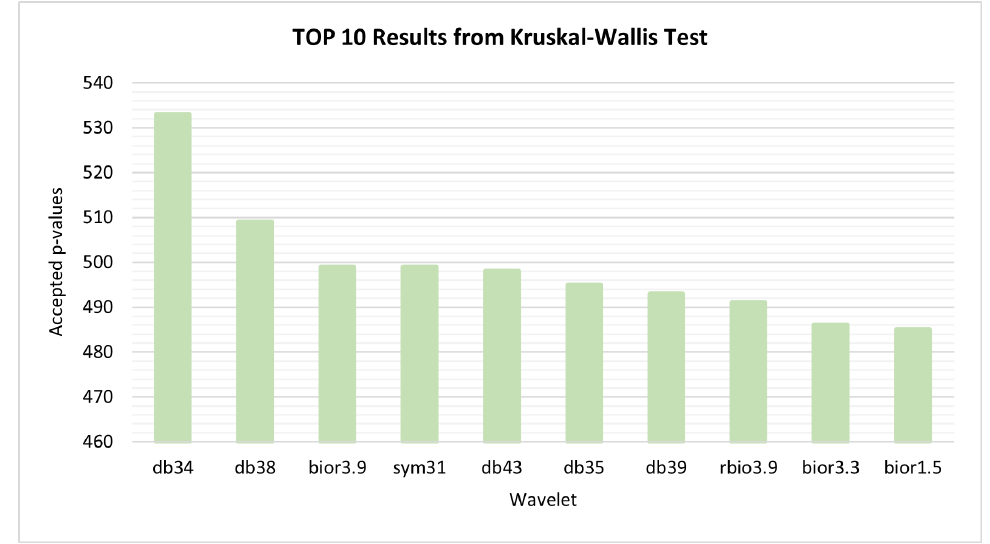
Figure 4. Kruskal–Wallis test—10 best performances achieved by